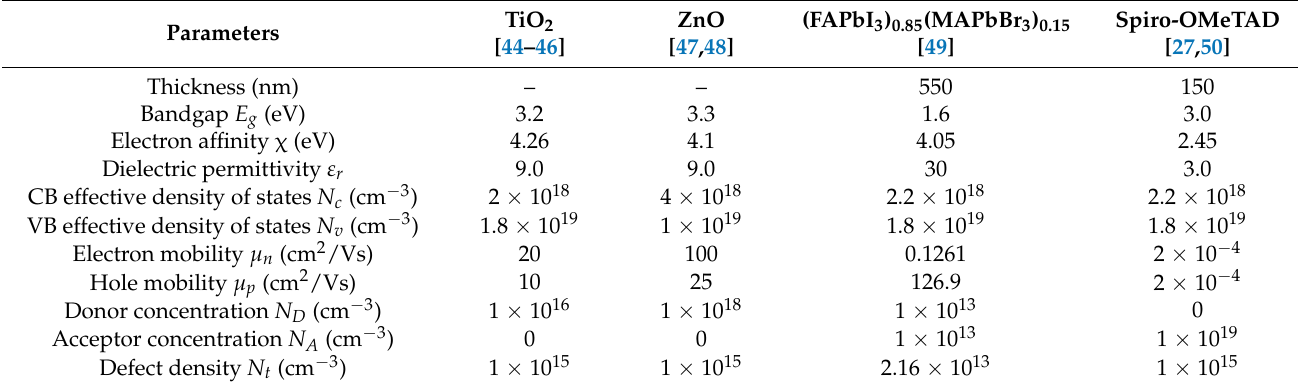
Table 1. Basic physical parameters of the various layers.